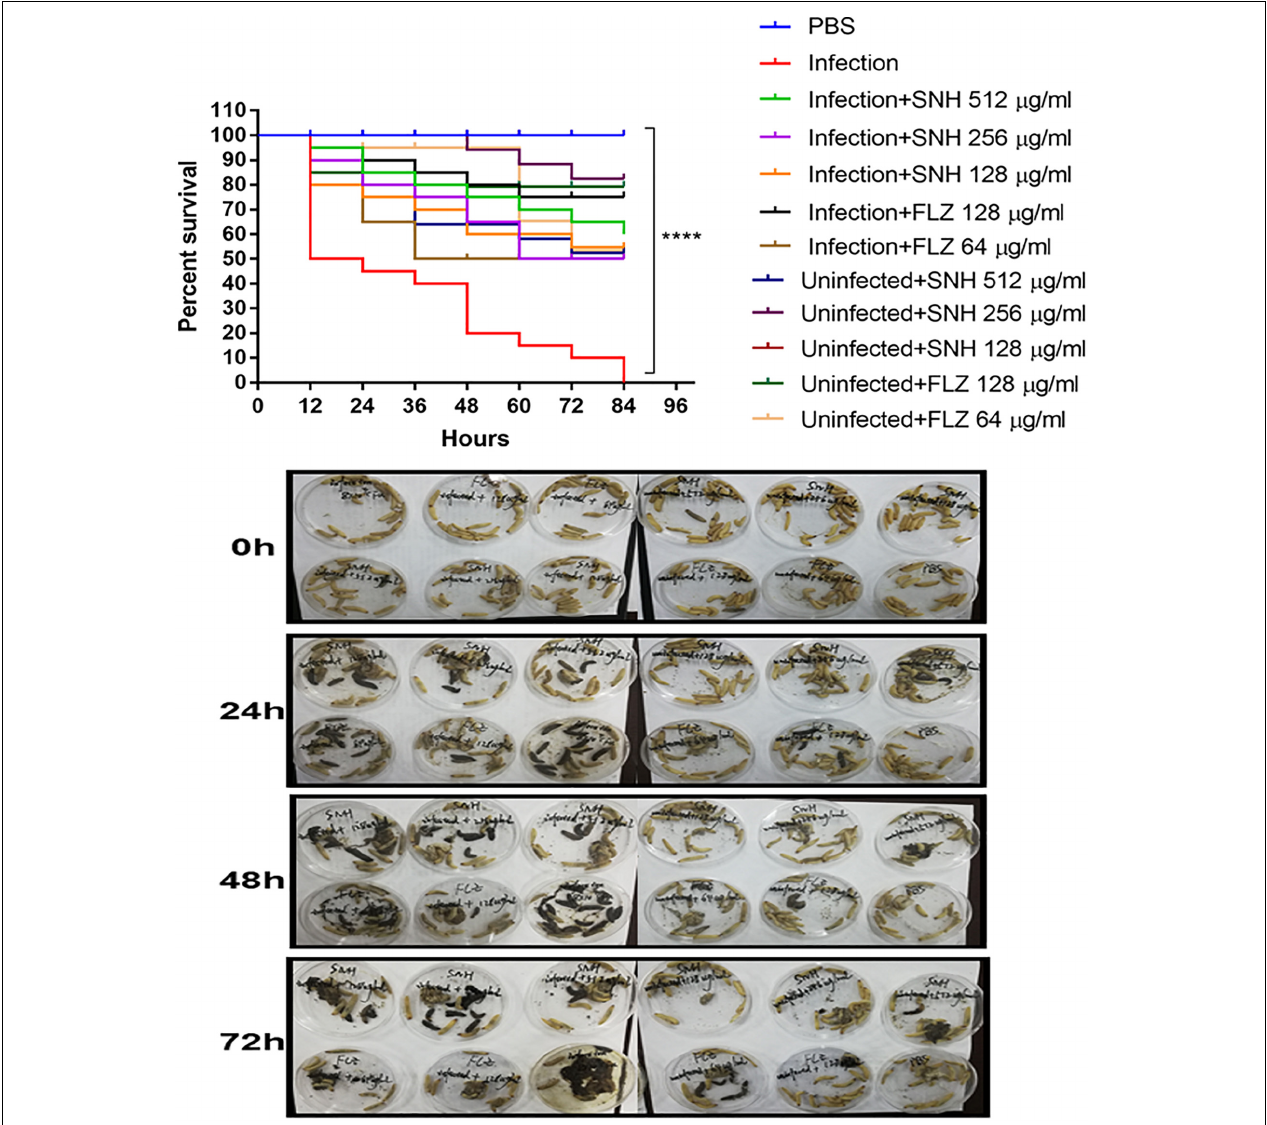
FIGURE 7 | In vivo evaluation of antifungal efficacy of SNH against C. albicans . Survival of G. mellonella larvae infected with LD 50 dose of C. albicans SC5314 strains (8 × 10 4 CFU/larvae) and treated with SNH 1 h post-infection. C. albicans SC5314 induced infection (10 µ L) was treated with SNH (10 µ L), keeping respective controls (infected, infected with FLZ-treatment, PBS). Data expressed as the mean of three independent experiments. Survival curves were plotted using the Kaplan-Meier method and statistical analysis were performed using the log-rank test for multiple comparisons. **** p <